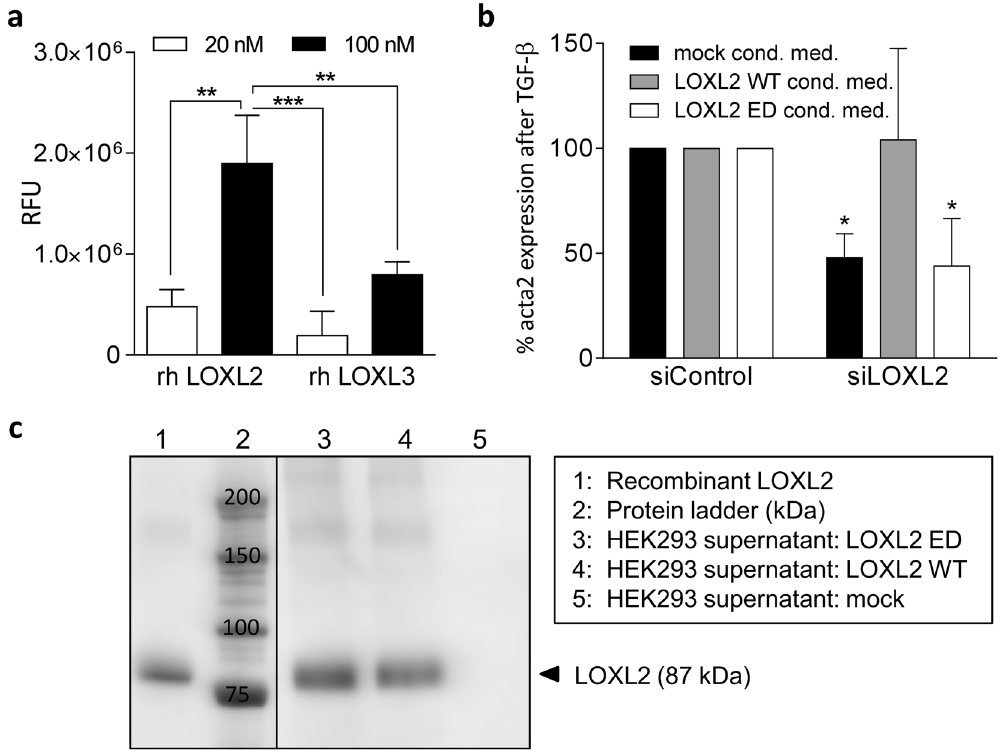
Figure 7. FMT is dependent on the enzymatic activity of LOXL2. ( a ) Comparison of collagen I crosslinking capacity of recombinant LOXL2 and LOXL3. Human lung collagen I coated microplates were incubated with LOXL2 or LOXL3, respectively, for 2 hours followed by aldehyde detection using O-(biotinylcarbazoylmethyl) hydroxylamine as a probe. Relative fluorescence units (RFU) indicate the amount of aldehyde intermediate in collagen I produced by LOXL2 and LOXL3, respectively. White bars indicate resulting fluorescence after incubation with 20 nM LOX/L, whereas black bars represent 100 nM of the respective enzyme. Data is shown as mean ± SD of three independent experiments. ** p < 0.01; *** p < 0.001. ( b ) NHLF cells were transfected with 16.6 nM of control or LOXL2 siRNA. After 12 hours, cells were incubated in conditioned medium derived from HEK293 cells transfected with LOXL2 wild type, LOXL2 enzymatic dead or control plasmids (mock). 24 h after transfection, cells were stimulated with TGF- β 1 (5 ng/ml) for 48 hours in presence of the respective conditioned medium. Gene expression changes of acta2 mRNA were determined using Taqman gene expression assays. Data are normalized to RNA-polymerase 2 expression and control treatment and presented as mean ± SD of three independent experiments. * p < 0.05, relative to siControl treatment. ( c ) LOXL2 protein content detected by LOXL2-specific Western Blotting, 72 hours after HEK293 transfection with the respective plasmids (10 µ l supernatant per lane).